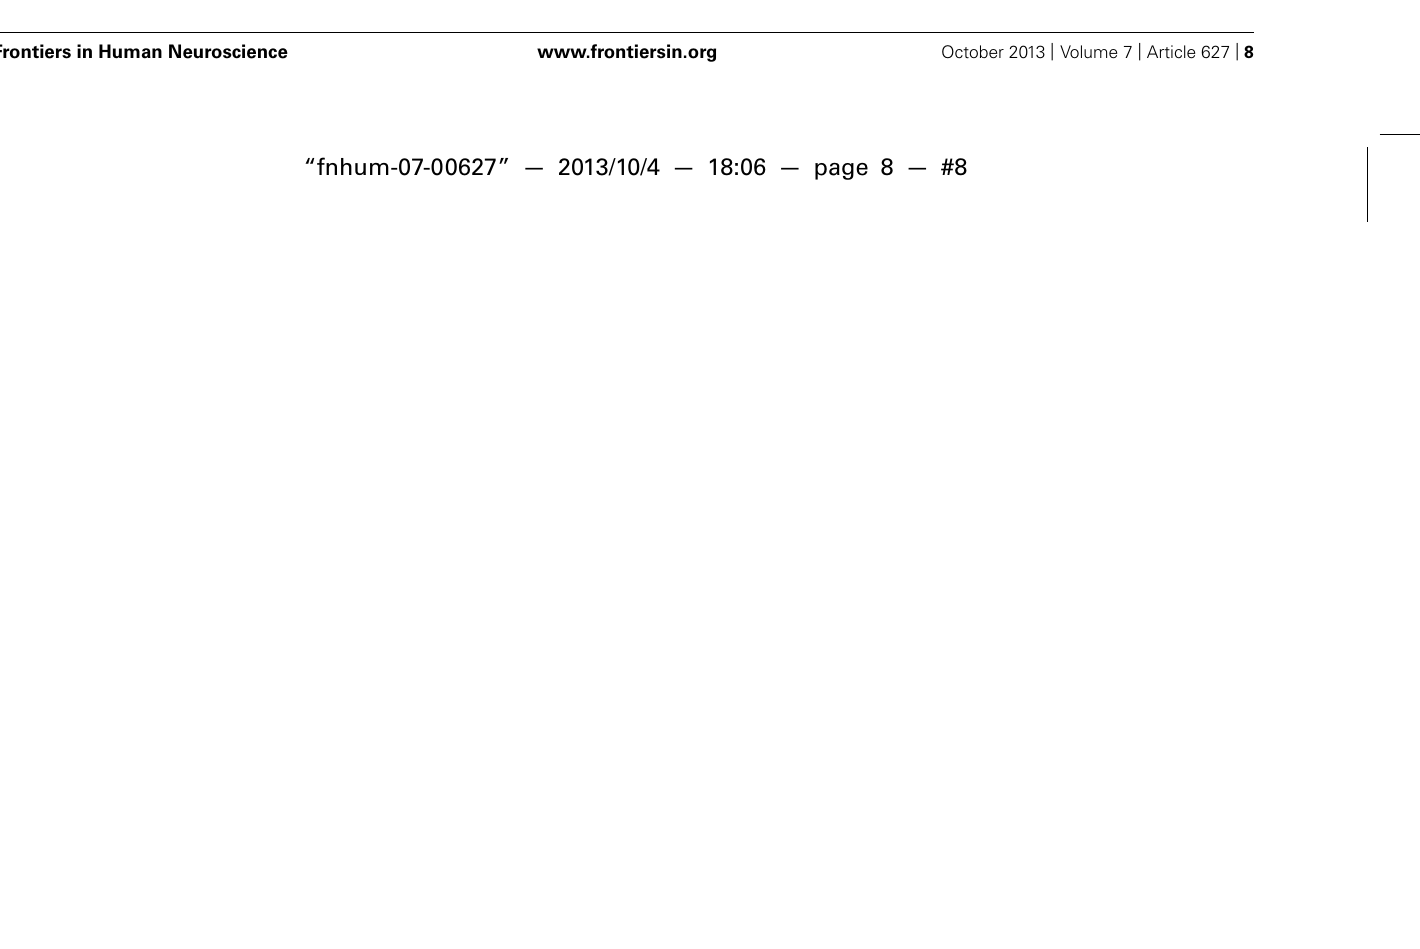
at shorter lags than longer lags ( F (5,70) = 11.36, p < 0.001, MSE =